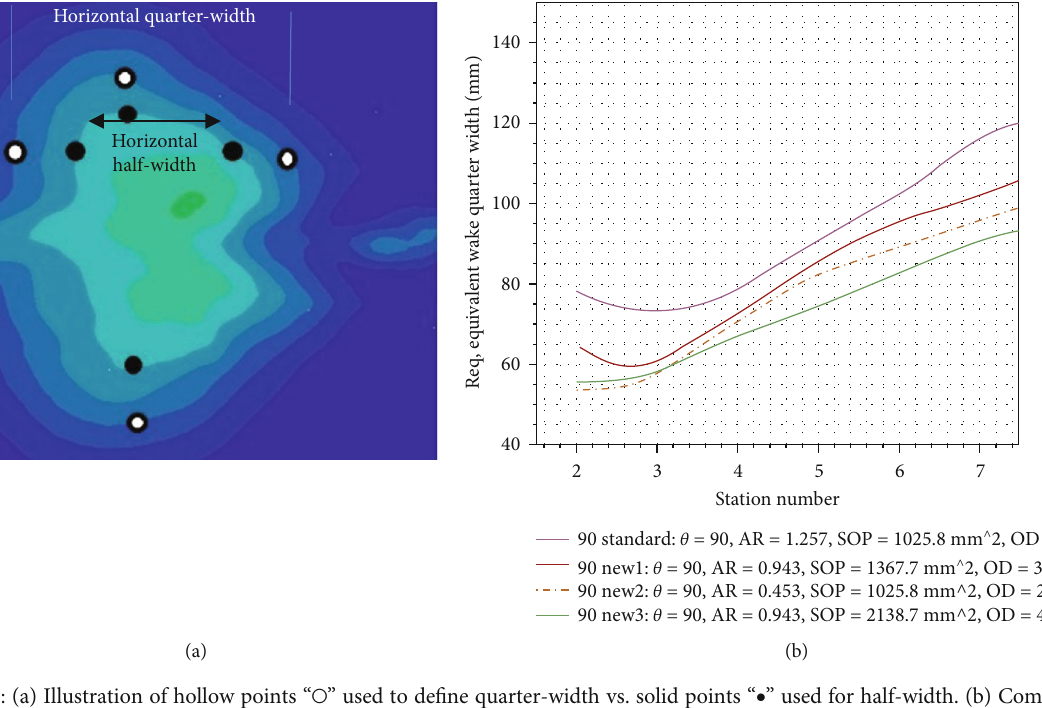
Figure 7: (a) Illustration of hollow points “ ○ ” used to de fi ne quarter-width vs. solid points “(cid:129)” used for half-width. (b) Comparison of the equivalent wake quarter-width variations at di ff erent stations for modi fi ed and standard 90 °